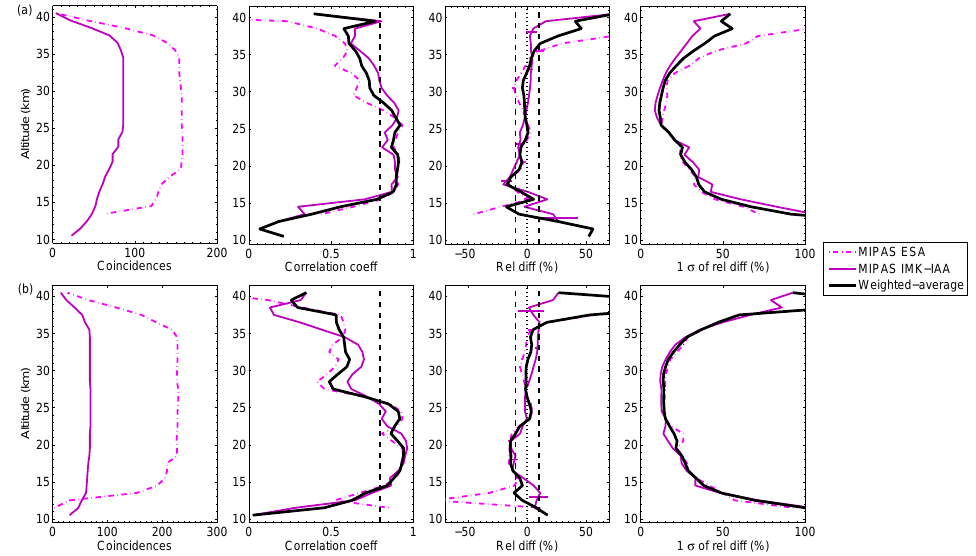
Figure 18. Comparisons of ACE-FTS ClONO 2 profiles with MIPAS data sets (ESA and IMK-IAA) using coincidence criteria of within 4h and 250km and only spring months (Feb–Apr in NH, Aug–Oct in SH). (a) Comparisons for local morning and (b) local evening. Error bars in the relative difference profiles represent the standard error of the